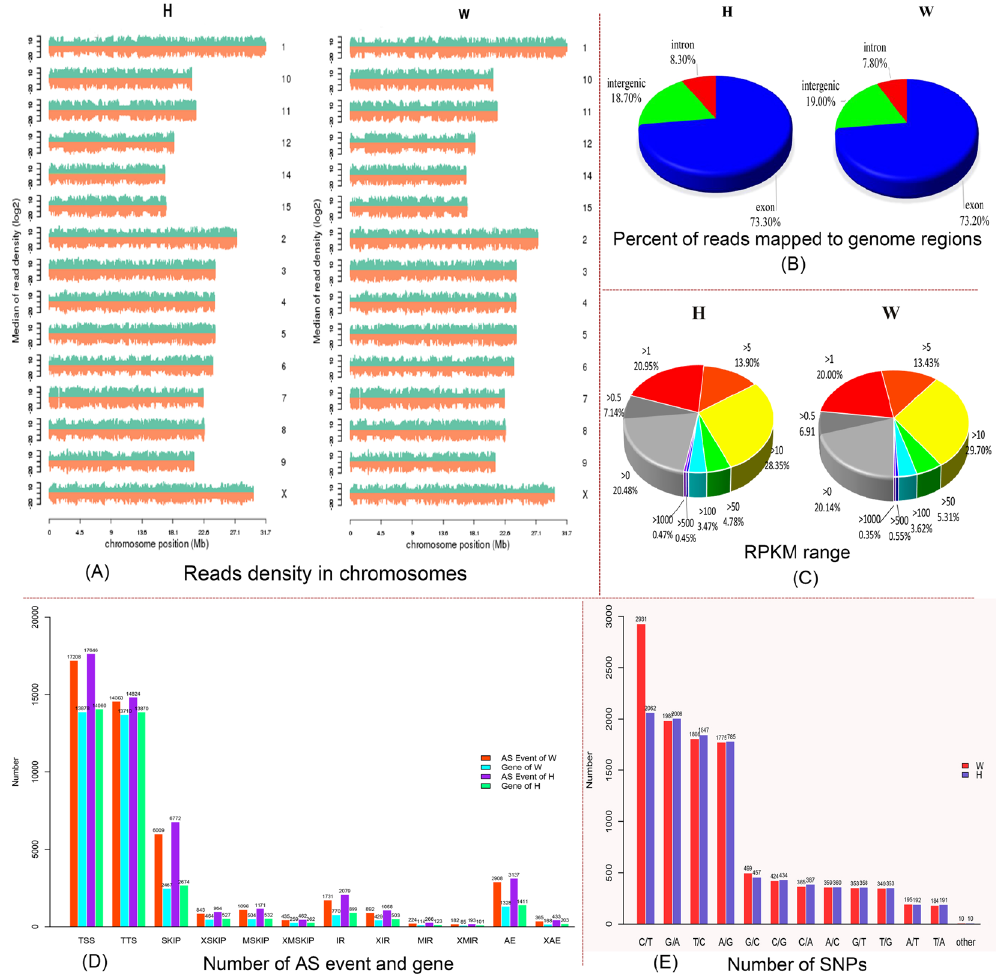
Figure 1. Summary of basic sequencing data. ( A ) Density of total mapped reads (W and H). X-axis represents position on chromosome (million base pairs), and Y-axis represents log2(median reads density). Green and red regions represent positive and negative strands of chromosome, respectively. ( B ) Percentage of reads mapped to different genome regions (W and H). ( C ) Percentage of genes with different expression levels (W and H). ( D ) Distribution of alternative splicing events and associated genes in W and H samples. The orange and the purple bars indicate the number of alternative splicing events identified in W and H libraries, respectively. The cyan and the spring green bars indicate the number of genes associated with each type of the 12 alternative splicing events. ( E ) Distribution of SNPs identified in W and H libraries. The red and the slate blue bars indicate the number of SNPs in W and H libraries,